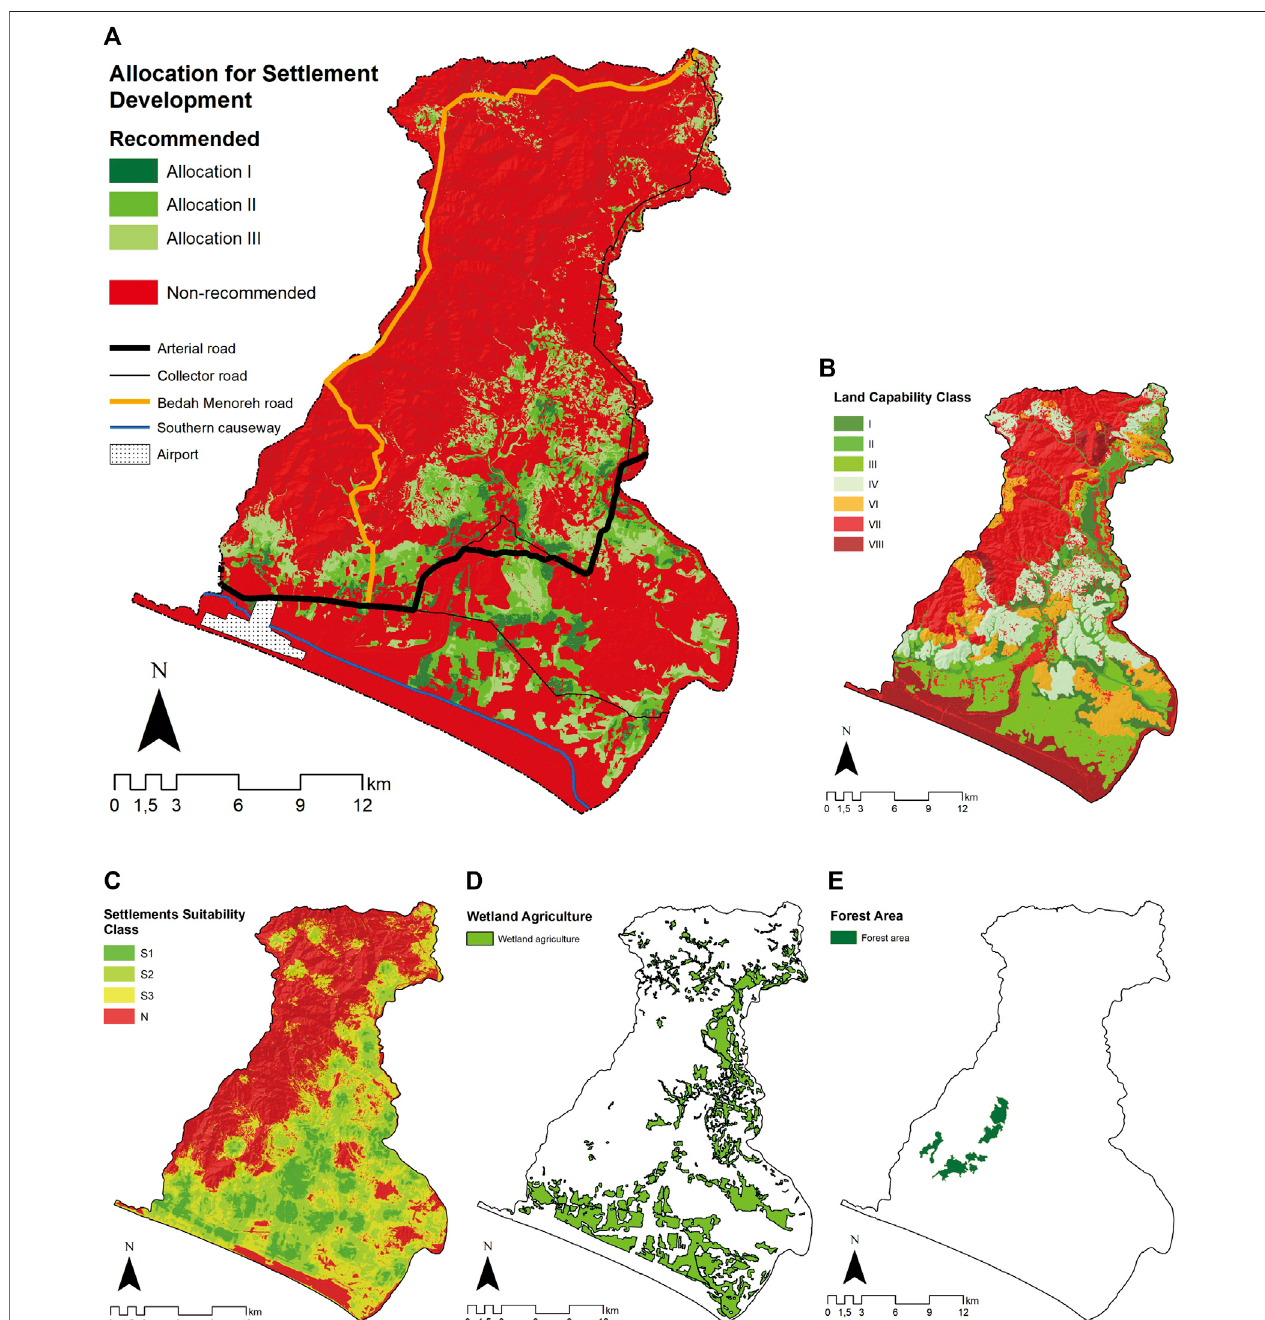
FIGURE 3 | Land allocation for settlement